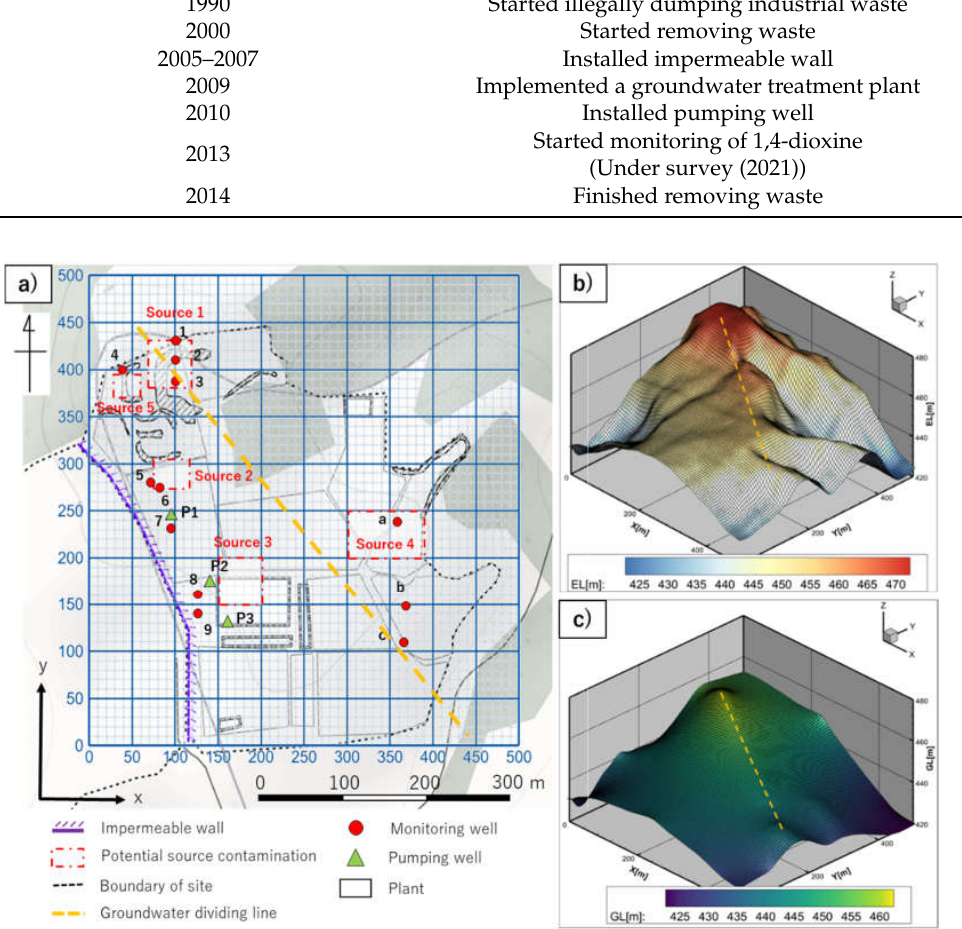
Figure 1. Map of an illegal waste dumping site. The blue grid means the calculated area. ( a ) Site map and simulation area. ( b ) Distribution of elevation level (EL) from a GIS. ( c ) Distribution of the groundwater level (GL). The EL and GL is the distance from the sea surface.